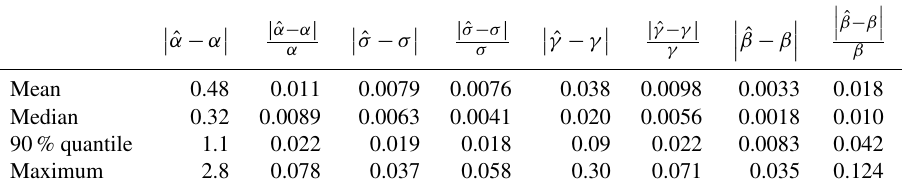
Figure 3. Examples of simulated cloud albedo distributions for diverse values of the parameters b (blue shades) and c (shown as diverse dashed lines) in Eq. (5). The example surface albedo values are assumed to be Gaussian, with mean values of 20% (a) , 50% (b) and 80% (c) and a standard deviation of 2%. The mean surface albedo is shown as a red line and the distribution as a yellow curve. The parameter p in Eq. (4) took a random value in the range [ 0 , 1 ] . The example cloud albedo value is assumed to be Gaussian, with a mean of 60% and a standard deviation of 20%. Table 2. Simulated statistics for the absolute and relative differences in estimated ( ∧ ) and true values of albedo ( α ), standard deviation ( σ ) skewness ( γ ) and kurtosis ( β ). The calculations were made for albedo values of 10%, 20%, 30%, 40%, 50%, 60%, 70% and 80%. The albedo values are in the range